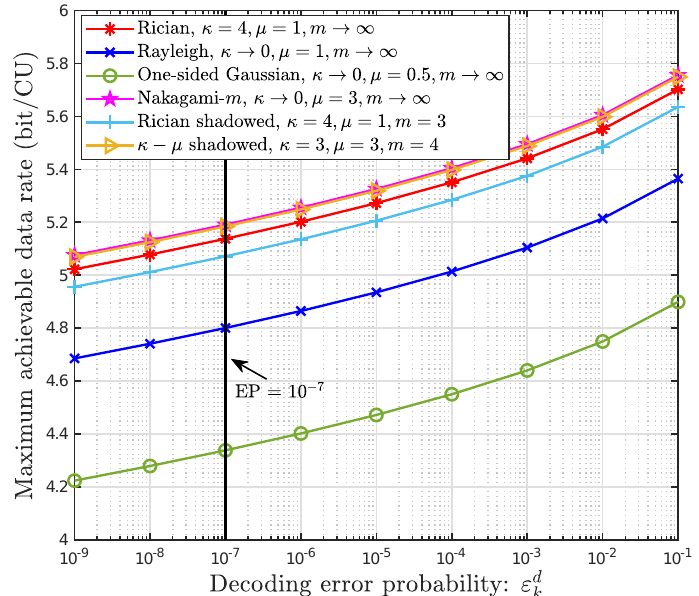
Figure 2. Relationship between the decoding error probability and the maximum achievable data